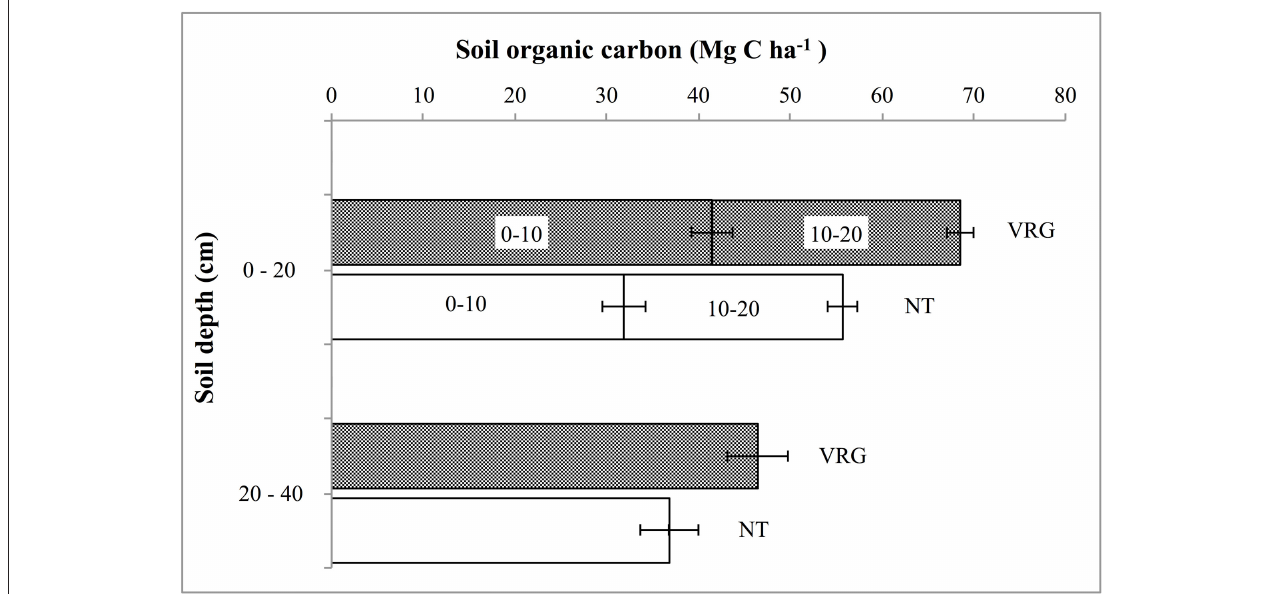
FIGURE 1 | Average ± SE of the distribution of organic carbon in the soil by depth for Voisin’s Rational Grazing (VRG) pasture management and for fields with No-tillage crop system (NT) in Western Santa Catarina State, Brazil ( n = 5).